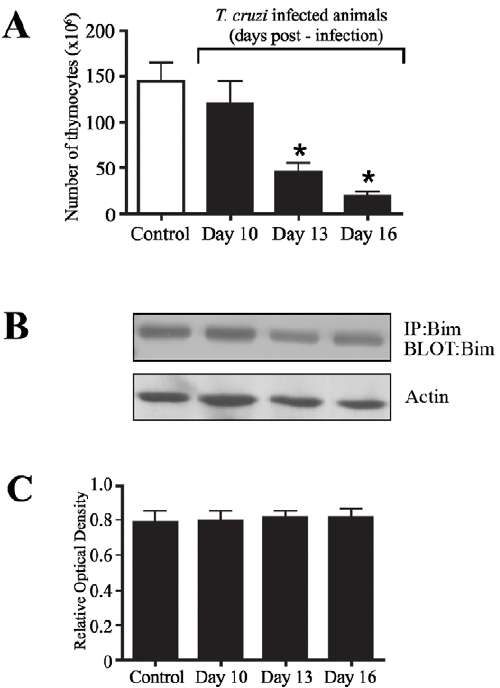
Figure 3. Intrathymic expression of Bim in the course of acute T.cruzi infection. (a) Thymuses were collected from normal or T cruzi infected BALB/c mice (day 15 post-infection). All numbers are given in 10 6 , and each value represents the mean of total thymocyte numbers in 4-8 mice per group. (b) From individual groups of the same experiments, DP cells isolated by cell sorting from thymus of infected mice at the indicated time-points or normal mice as controls were lysed and proteins were solubilized by detergent lysis and immunoprecip- itated with anti-Bim antibody for Western blotting analysis probing with the same antibody. The upper blot shows kinetics of the Bim expression from day 10 to 16 post-infection, during the thymic atrophy, whereas the lower panel reveals a blot was probed with actin, applied as a loading control. (c) Optical densitometry of the western blots using NIH Image software, where Bim expression was normalized with the actin expression. The data are representative of three independent experi- ments. *Differences between control versus infected mice are significant ( P , 0.05). These data are representative of two independent experi- ments using five mice per group.